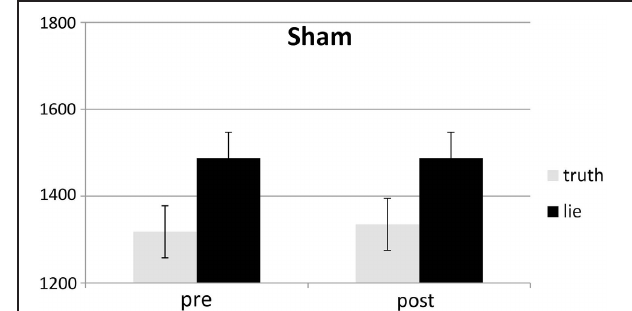
FIGURE 4 | Mean RTs (ms; ± one SE) for lie and truth trials, pre and post real rTMS.